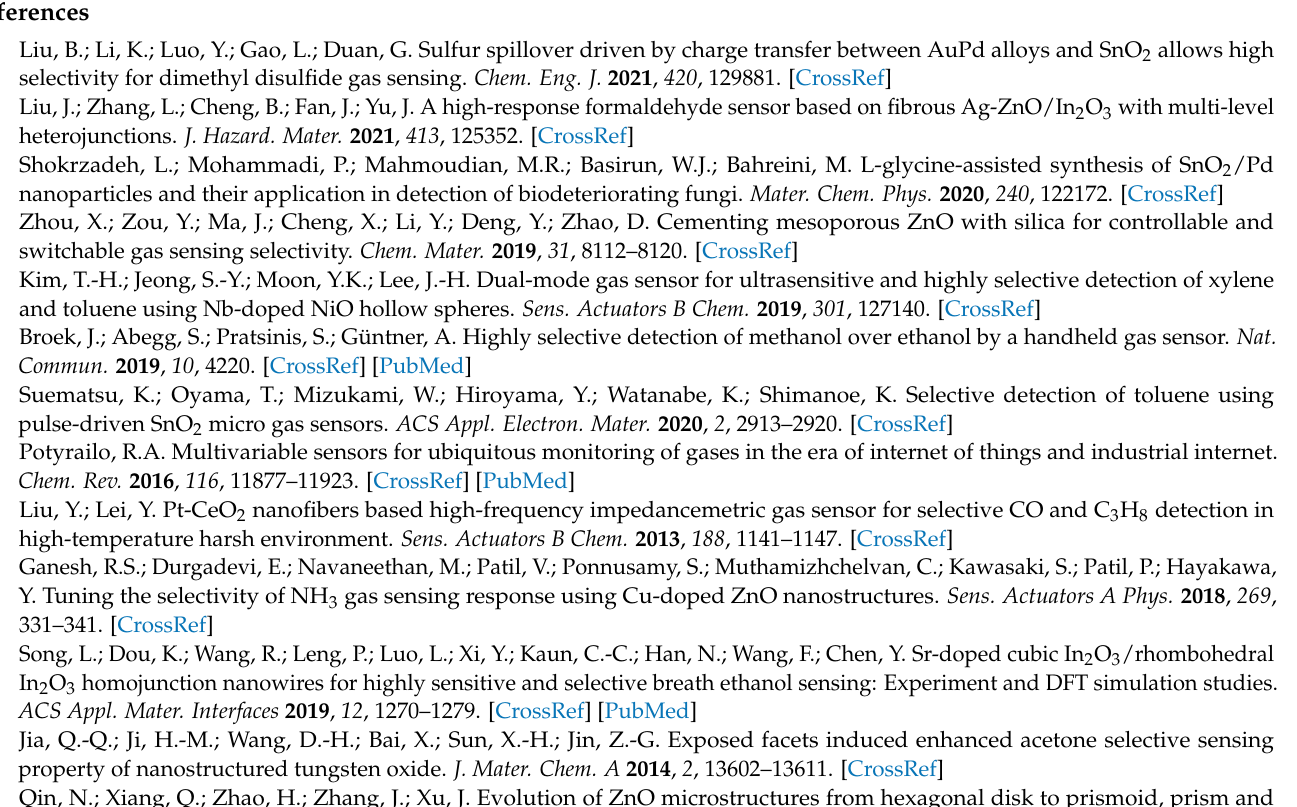
Figure S1: Schematic top view of the O/Zn ions in the slabs; Table S2: The Bader charge states of O/Zn ions; Figure S2: Schematic top view of atoms in 1 × 2 × 1 supercell of ZnO Table S3: The Bader charge states of O/Zn ions in ZnO